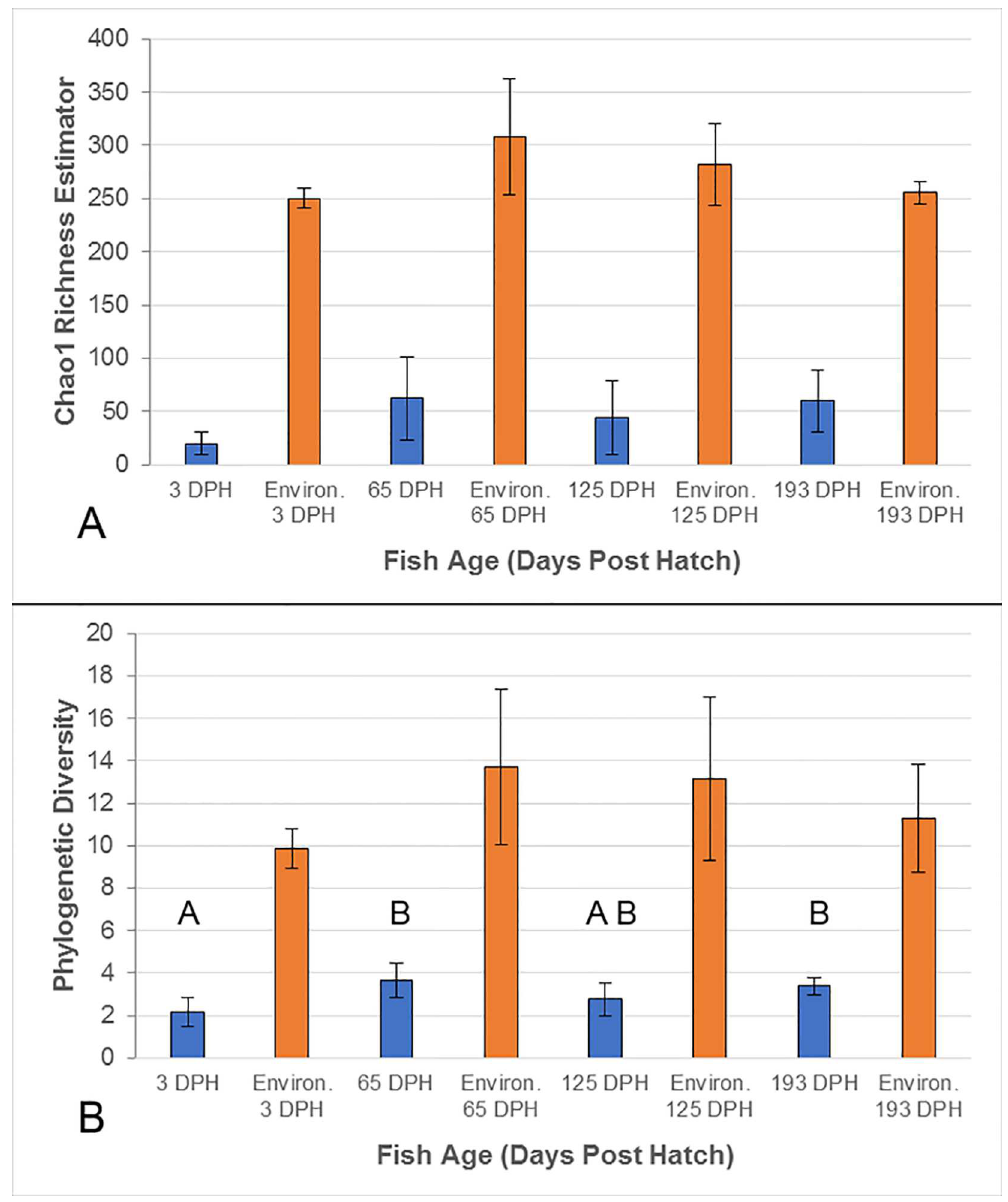
Fig 2. Alpha diversity of the intestinal microbiota of channel catfish and the combined environmental microbiota (administered diets and water-supply) at each sampling point (days post hatch, DPH). Bars represent the group means of fish samples (blue) and the environmental samples associated with fish at each time point (orange),with error bars displayingthe SD. Alpha diversity is represented by Chao1species richness estimator (A) and whole-treephylogenetic diversity (B). An ANOVA followedby Tukey’s post-hoc test was conductedacross all intestinalsamples to detected differencesin alpha diversity over time (P (cid:20) 0.05). No differences were detected for Chao 1 (A), while letters indicate significantdifferences detected in phylogenetic distance(B). Two-tailed Welch t-tests detected significantdifferences (P < 0.05) betweenthe intestinalsamples and the combinedenvironmental samples at all time points, based upon either